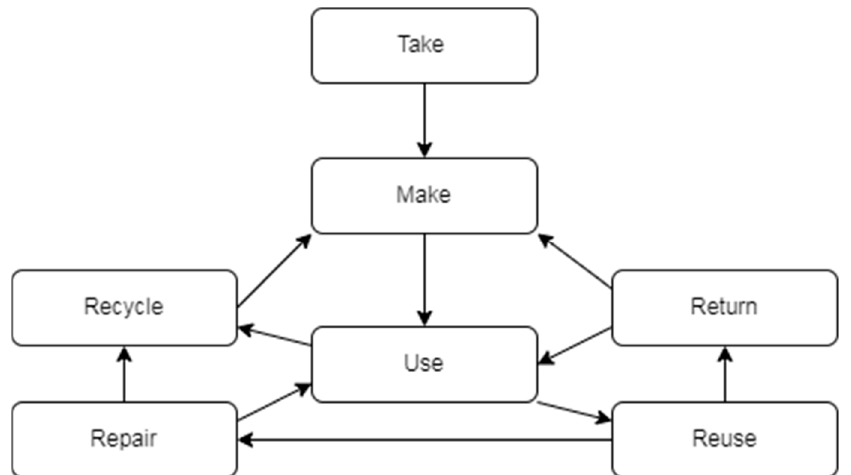
Figure 1. Circular economy for WCO